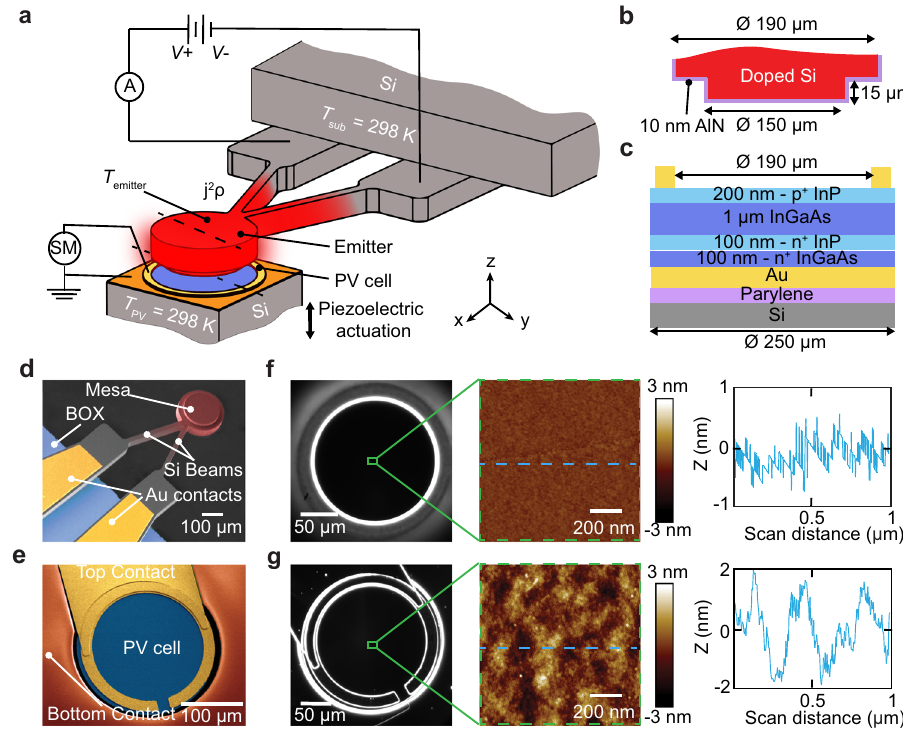
Fig. 1 Devices and experimental setup. a Schematic depiction of the experimental setup employed for near- fi eld thermophotovoltaic measurements. The custom-fabricated Si emitter features a suspended mesa (see panel d ) that is Joule heated (heat dissipation quanti fi ed with an ammeter ‘ A ’ ) up to1270 K by applying a bipolar voltage ( V + , V − ) to the two beams. The epitaxially grown InGaAs photovoltaic (PV) cell is moved towards the emitter via a piezoelectric actuator to systematically control the gap size while the electrical power generated is quanti fi ed with a source meter (SM). The emitter substrate and the PV cell are at a temperature of ~298 K. b, c , Cross-sectional pro fi les of the emitter and the PV cell at the sections along the black dashed lines in Fig. 1a. d , False-colored scanning electron micrograph (SEM) of the emitter with mesa, showing the buried oxide layer (BOX) and the gold contacts on the Si beams. The Si beams featuring a temperature gradient are depicted in red. e , False-colored SEM of the PV cell showing the central active layer of the PV cell (blue) as well as top (yellow) and bottom (orange) Au contacts. f, g , Dark- fi eld microscope (left panels), atomic-force microscopy (AFM) images (middle panels), and surface roughness pro fi les (corresponding to the blue dashed lines in the AFM images) of the mesa (f) and the PV cell (g) are shown in the right panels. The peak – peak roughness of the mesa is ~1 nm, while that of the PV cell ’ s active surface is ~4